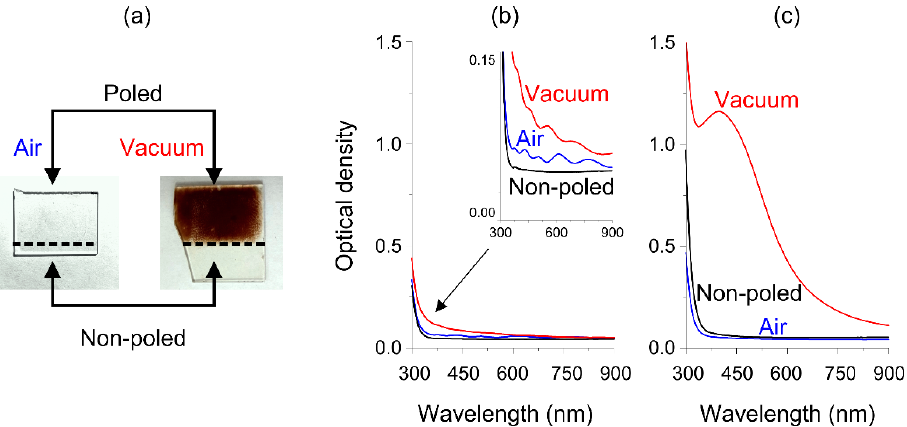
Figure 1. ( a ) Photographs of the ion-exchanged glasses poled prior the ion-exchange. The border between poled and unpoled glass regions is marked with a dash line, and the air- and vacuum- poled samples are indicated “Air” and “Vacuum”, respectively. ( b ) Optical absorption spectrum of non-poled glass and air- and vacuum-poled glasses before and ( c ) after the ion-exchange.